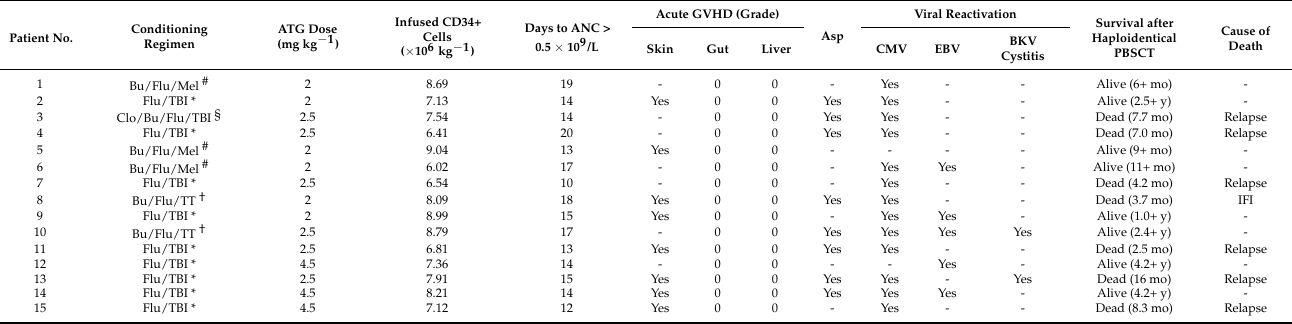
Table 2. Transplant-related information and